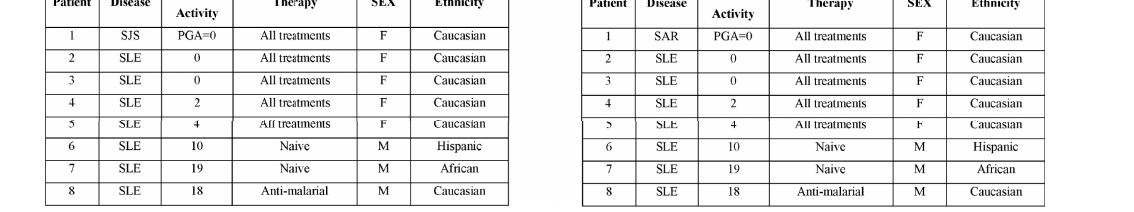
FIGURE 6 | Predictive value of SLAMF expressing populations for SLE. (A) ROC curves of SLESMB, SLEcTFH and SLEB1 and of their combinations in cohort1. (B) ROC curves of SLESMB, SLEcTFH and SLEB1 and of their combinations in cohort 2. (C) Samples of cohort 2 identi fi ed by combining SLESMB-SLEcTFH and